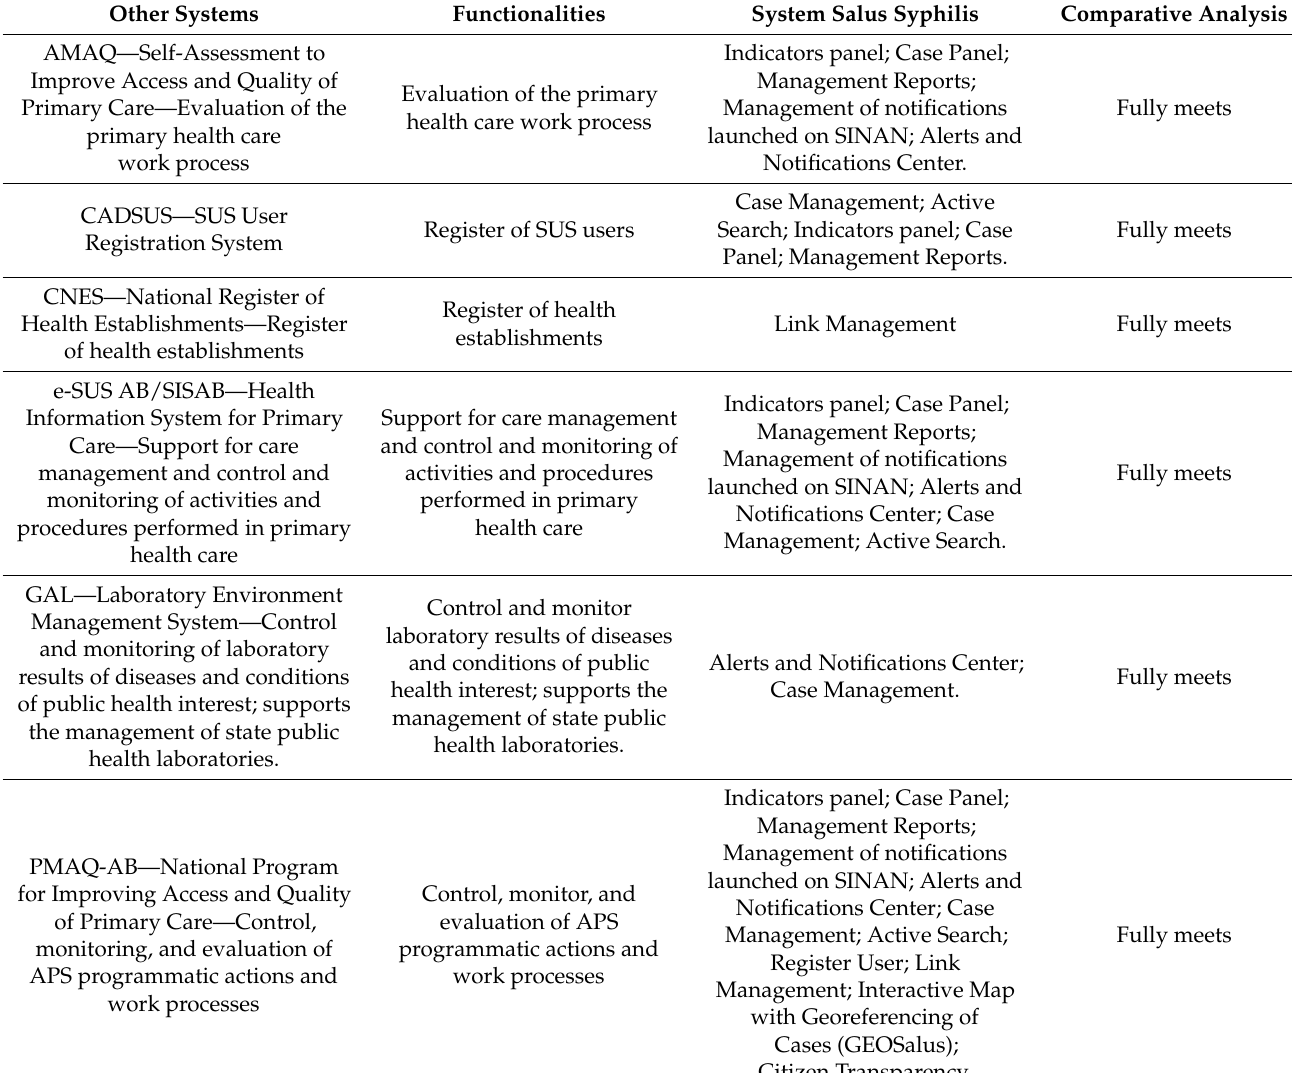
Table 1. Comparative analysis of the functionalities of the Health Information Systems (SIS) used in Brazil between 2010 and 2018, with those contemplated in Salus. Source: Adapted from